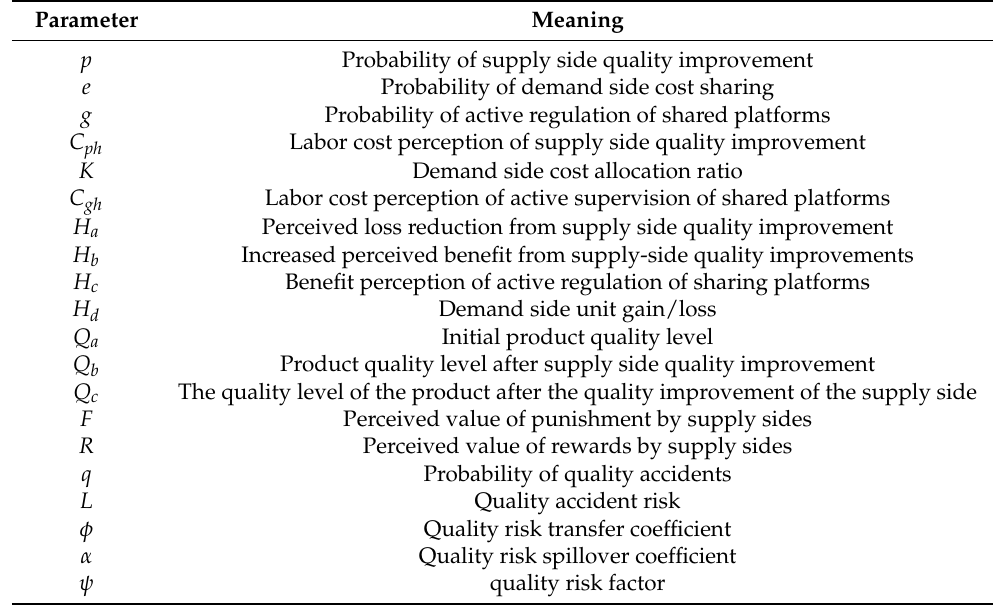
Table 2. Parameter symbols and their